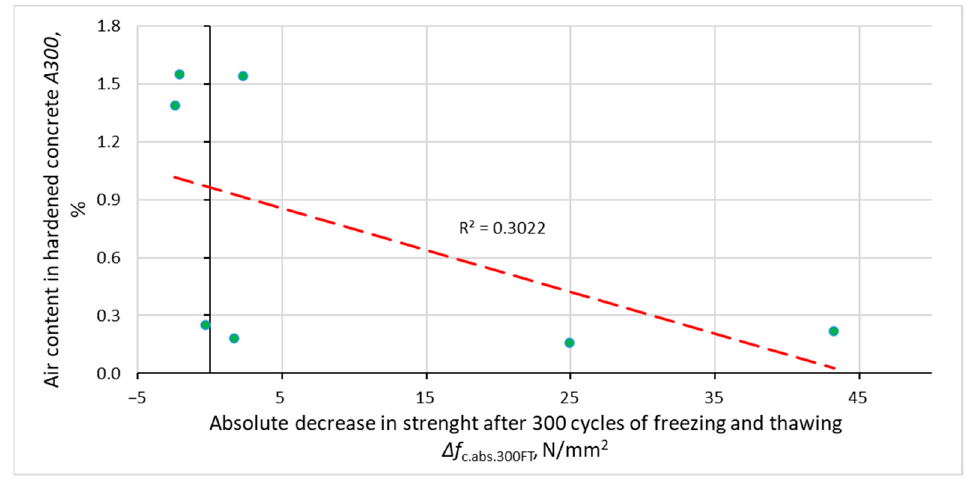
Figure 8. Dependence of the decrease in the compressive strength of concrete after 300 cycles of freezing and thawing on the total amount of air in the hardened concrete.